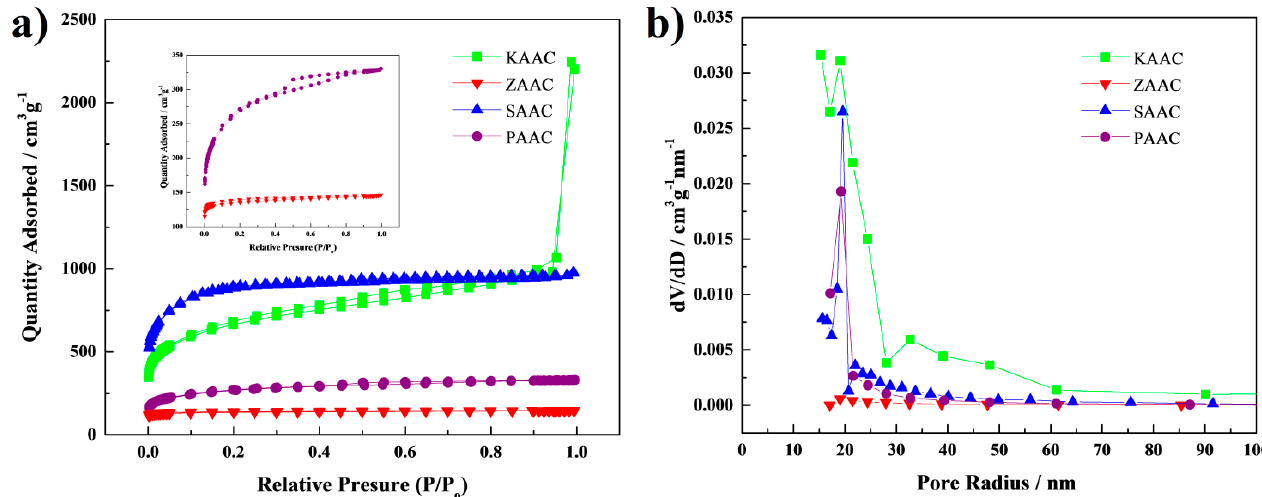
Figure 4. ( a ) Nitrogen adsorption–desorption isotherms and ( b ) pore sizes